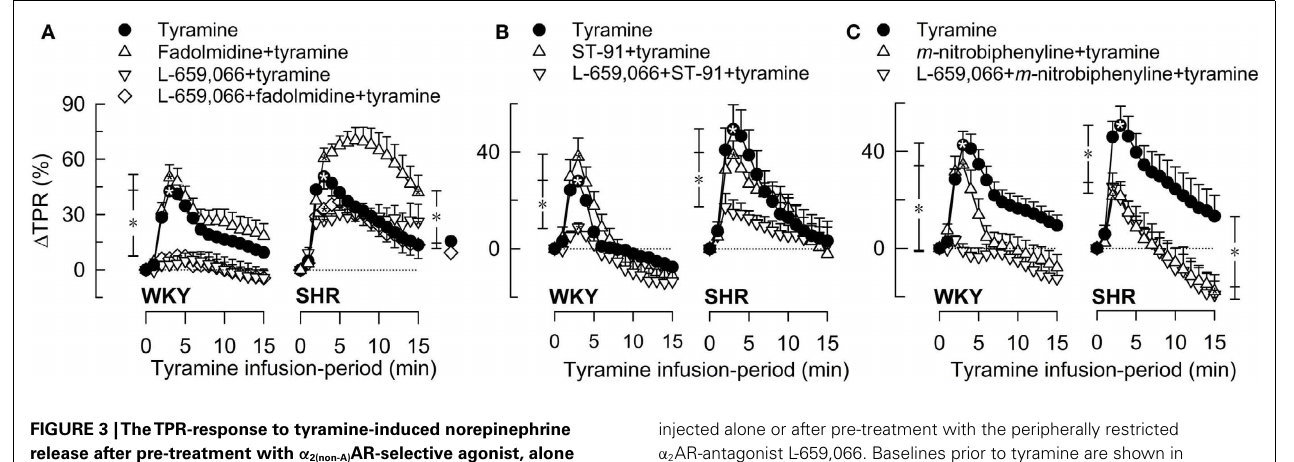
injected alone or after pre-treatment with the peripherally restricted FIGURE 3 |TheTPR-response to tyramine-induced norepinephrine α release after pre-treatment with α 2(non-A) AR-selective agonist, alone 2 AR-antagonist L-659,066. Baselines prior to tyramine are shown in or combined with L-659,066 .The peripherally restricted Table 3 . Significant responses (*within symbol) and differences α between the control and experimental groups were located at peak 2C > B > A AR-agonist fadolmidine (A) , the peripherally restricted α α response ( * brackets left of curves) and at 15min ( * brackets right of 2(non-A) AR-selective agonist ST-91 (B) , and the 2C -selective agonist m -nitrobiphenyline with additional α 2A + B AR-antagonistic activity (C) were curves). *, * P ≤ 0.025 after curve evaluations.